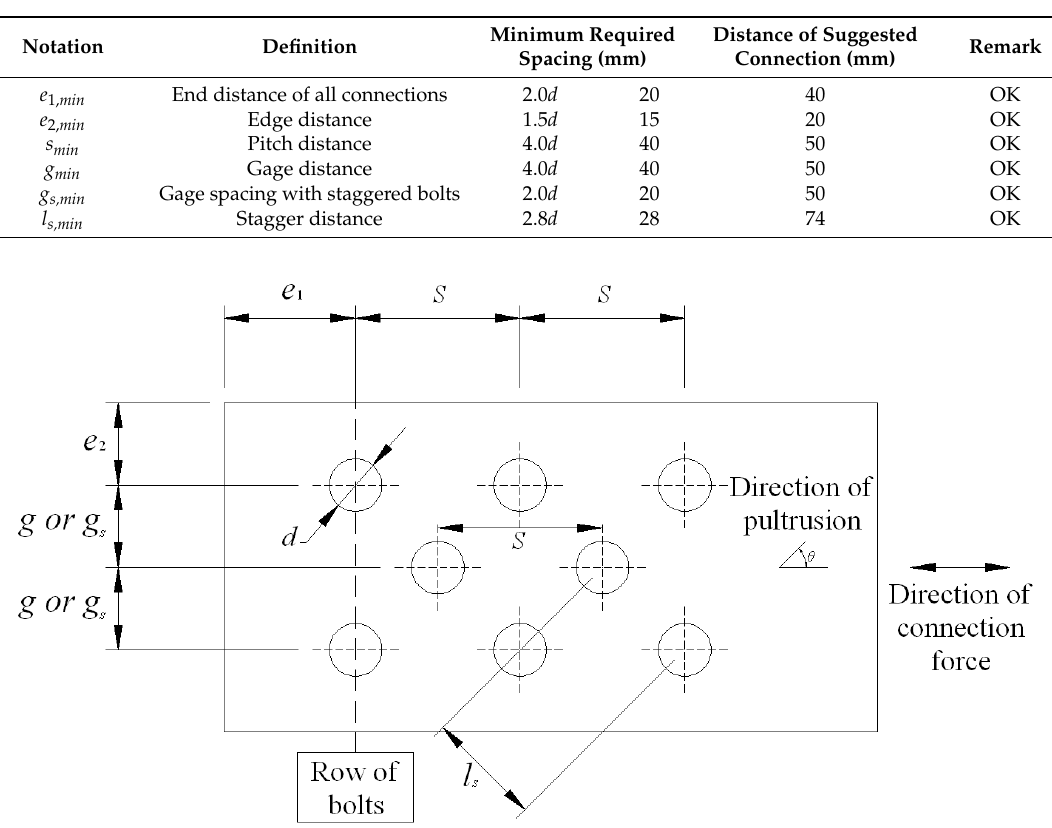
Figure 7. Connection geometry and definition for a row of bolts [12].